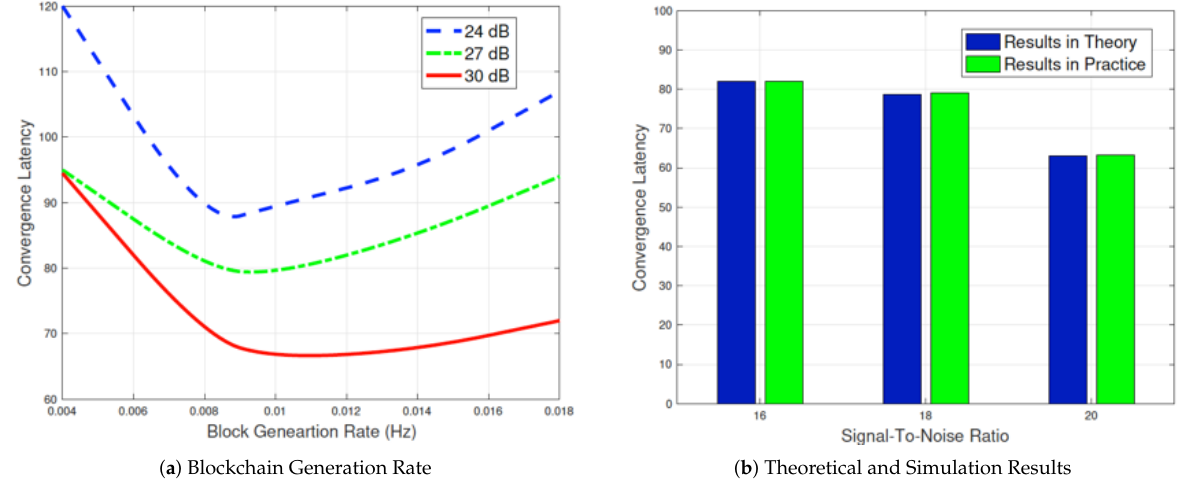
Figure 7. Blockchain evaluation regarding blockchain generation